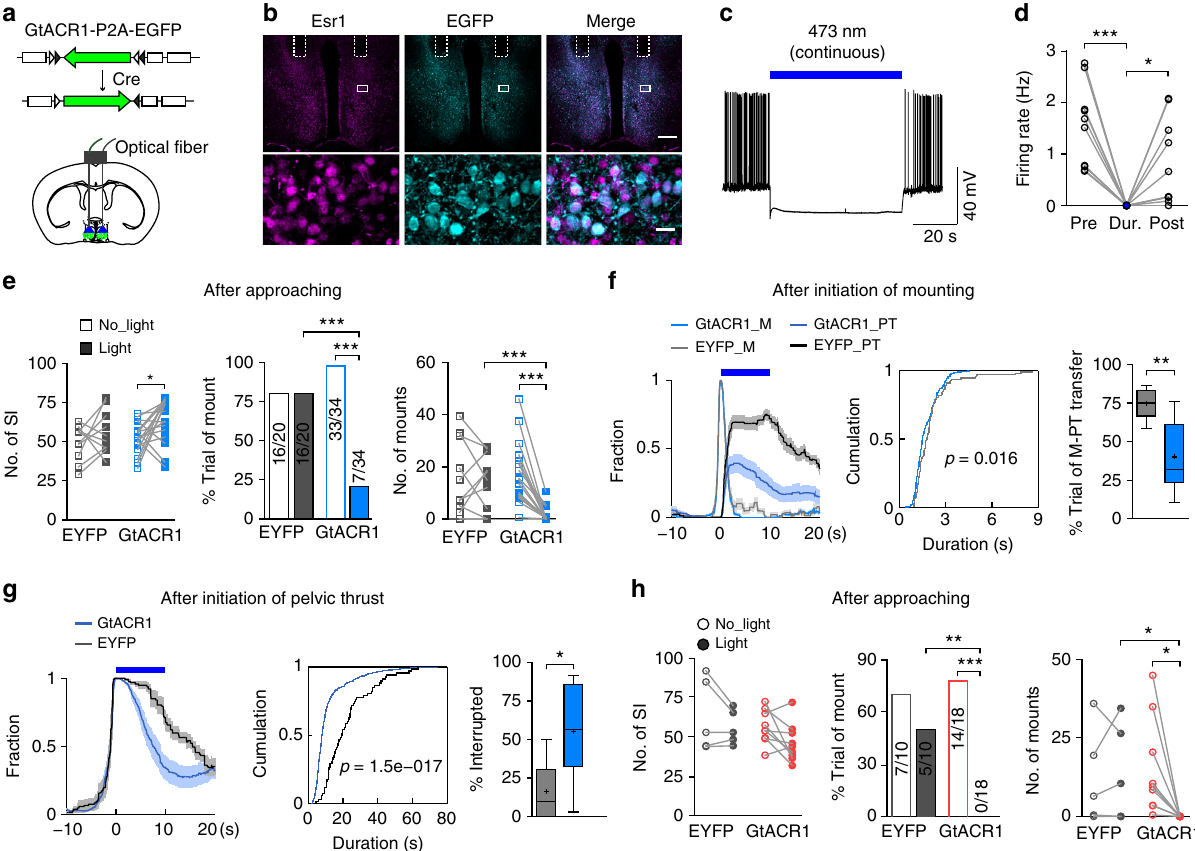
Fig. 8 Optogenetic inhibition of mPOA Esr1 + neurons disrupts male-typical mating in both sexes. a Schematics of the strategy to optogenetically inhibit mPOA Esr1 + neurons. b Representative images showing expression of GtACR1 as indicated by EGFP in Esr1+ neurons. Scale bar, 300 μ m, top; 20 μ m, bottom. c Electrophysiological recordings of GtACR1-expressing neurons. Action potentials induced by withholding the membrane potential − 48 mW with a current injection of 25 pA were blocked under continuous blue light stimulation. d Quanti fi cation of fi ring rates before (pre), during (dur.), and after (post) light stimulation. N = 5 male cells and 5 female cells. Paired t test. e Light delivery was triggered when the tested animal was within one body length distance to the female stimulus. Number of social investigation, percentage of trials with mount behavior and number of mounts for GtACR1 and control males in light and no-light trials were plotted and compared. N = 10 EGFP and 17 GtACR1 males. f A 10 s light pulse was delivered after the initiation of mount. The distribution of mount (M) and pelvic thrust (PT), the cumulative distribution of mount duration and the percentage trials with mount transitioning into pelvic thrust were plotted and compared between EYFP and GtACR1 males. N = 7 EYFP and 9 GtACR1 males. g A 10 s light pulse was delivered after the initiation of pelvic thrust. The distribution of pelvic thrust (PT), the cumulative distribution of duration of pelvic thrust and the percentage trials with pelvic thrust terminating during light stimulation were plotted and compared between EYPF and GtACR1 males. N = 7 EYFP and 9 GtACR1 males. h Females were treated with subcutaneous injection of testosterone. Light delivery was triggered when the tested animal was within one body length distance to the female stimulus. Number of social investigation, percentage of trials with mount behavior, and number of mounts in GtACR1 and control females during light or no-light trials were plotted and compared. N = 5 EYFP and 9 GtACR1 females. In e and h , t test or Wilcoxon rank-sum test, left and right, Fisher ’ s exact test, middle. In f and g , two-sample ks-test, middle, unpaired t test, right. * p < 0.05, ** p < 0.01, *** p <